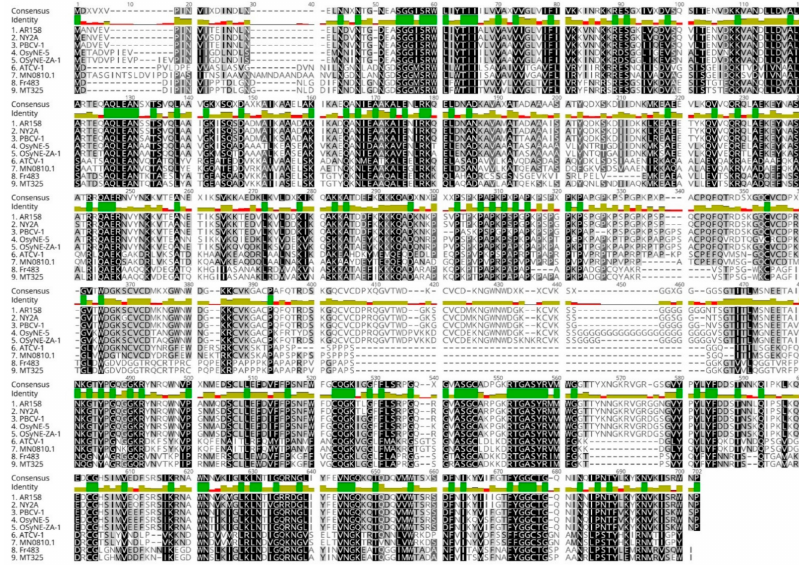
Figure 9. ClustalW alignment of A561L homologs among representatives of four clades of chloroviruses. The similarity of amino acids in the sequence alignment is shown as follows: black being identical, different shades of gray (different levels of conservation) and white not conserved. On the top ribbon: green color denotes identical amino acids. Other shades of amino acids indicate a level of conservation from olive color as being the most conserved to red color not conserved. AR-158, NY-2A along with PBCV-1 are NC64A viruses; OsyNE-5 and OsyNE-ZA-1 infect Syngen strain; ATCV-1 and MN0810.1 are SAG viruses; Fr-483 and MT325 are Pbi viruses. A561L D1 domain ends at aa 93, domain A561L D2 stretches from aa 94 to aa 338, domain A561L D3 runs from aa 339 to aa 456 and domain A561L D4 starts at 457